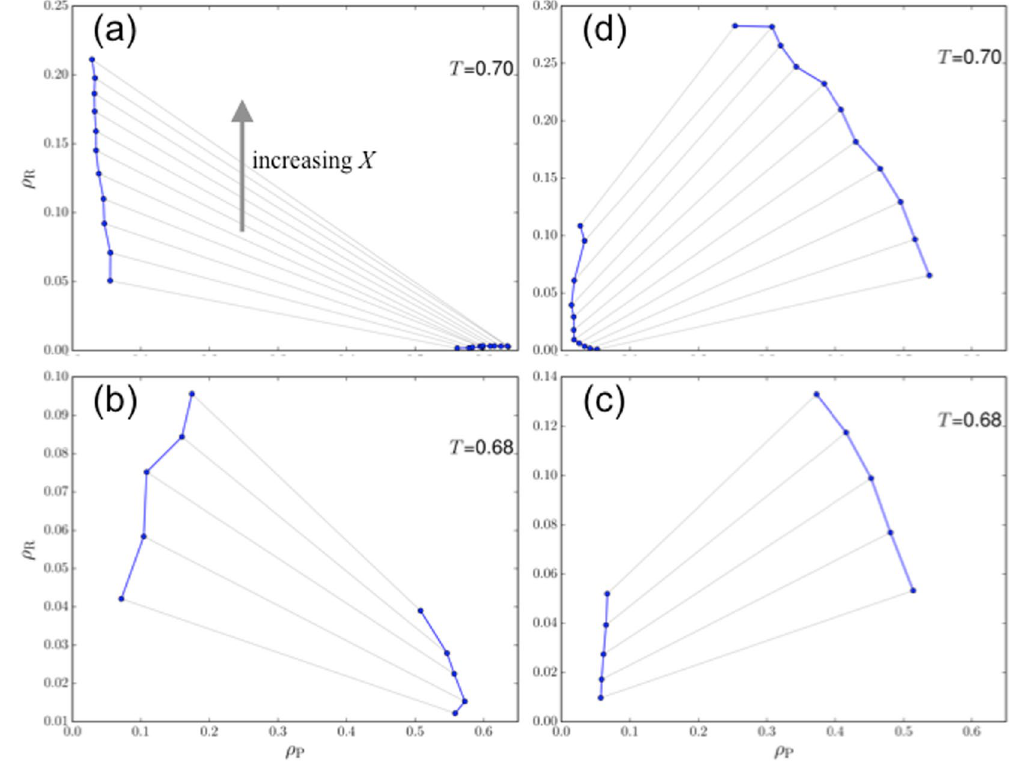
Figure 3. Partitioning of P and R particles in the two phases. Results at ε PR = 0.0, 0.5, 1.0, and 1.35 are shown in ( a – d ), respectively, at the temperatures indicated. A pair of points connected by a black line represent ρ ρ ( , ) PI RI and ρ ρ ( , ) PII RII for the system at a given X